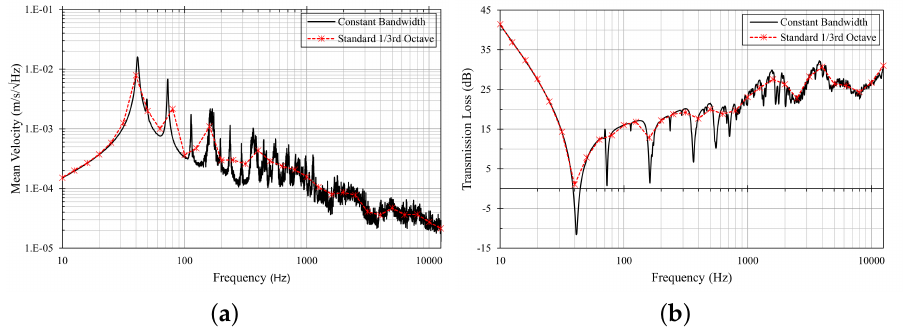
Figure 8. Analytical vibro-acoustic responses: ( a ) space-average mean vibration velocity and ( b ) sound transmission loss.